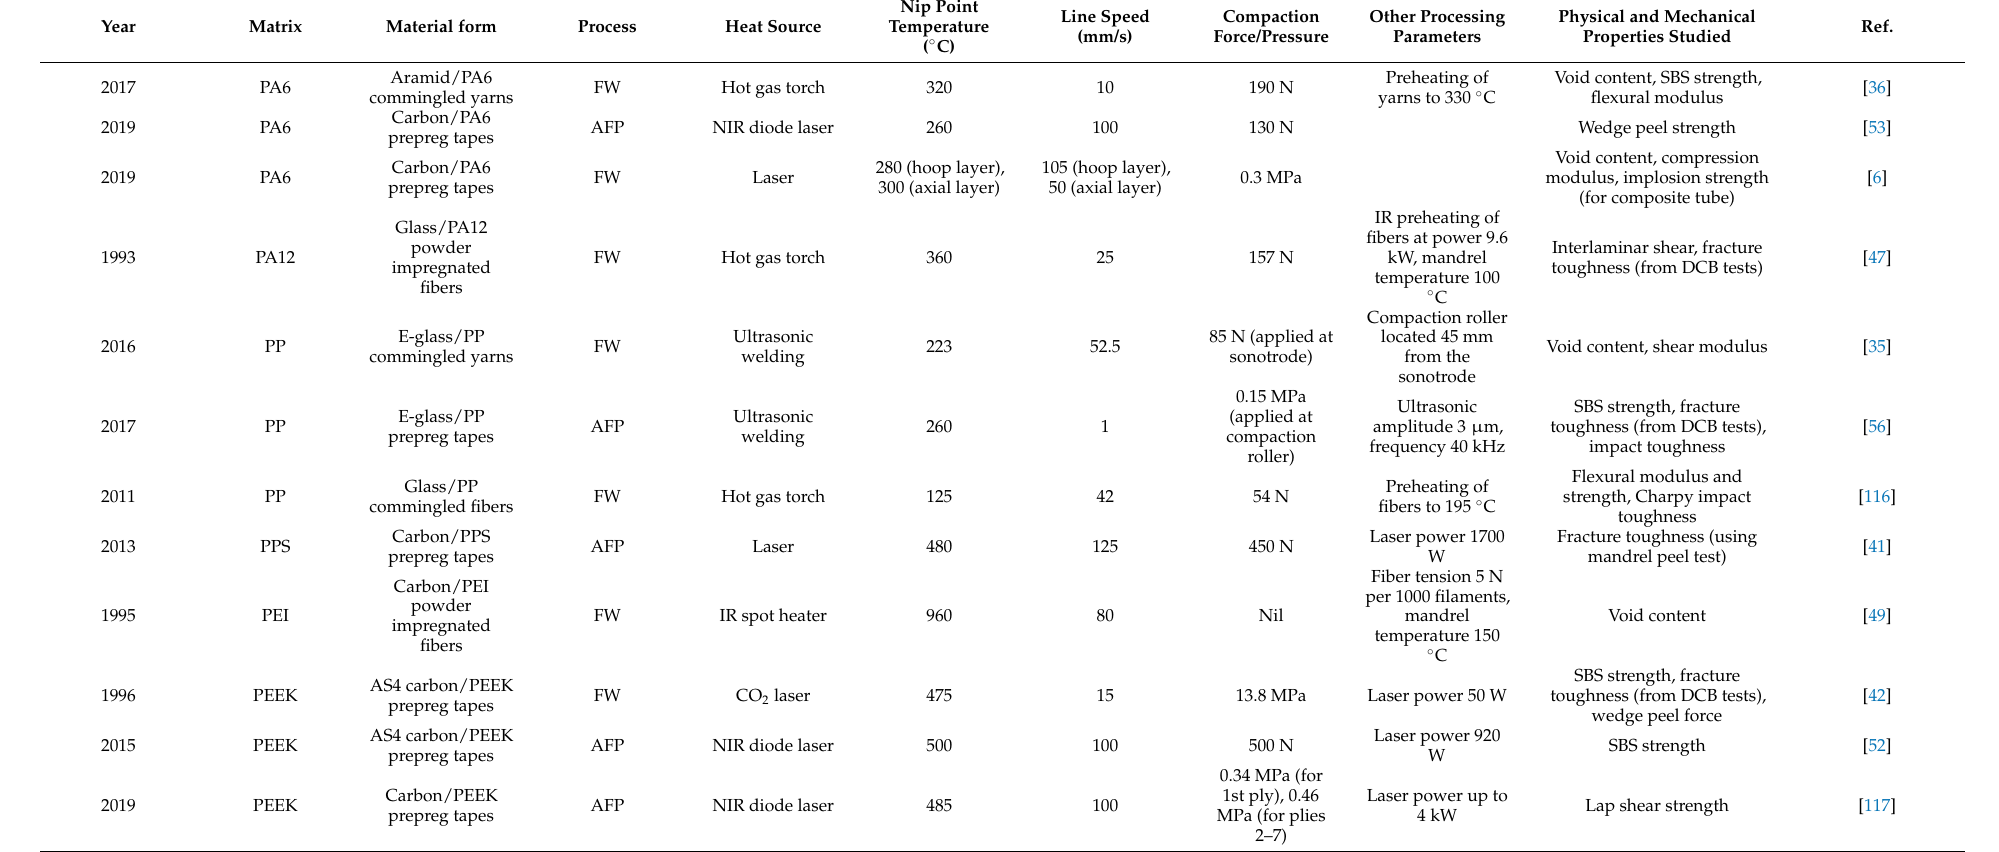
Table 1. Summary of optimized processing parameters from past